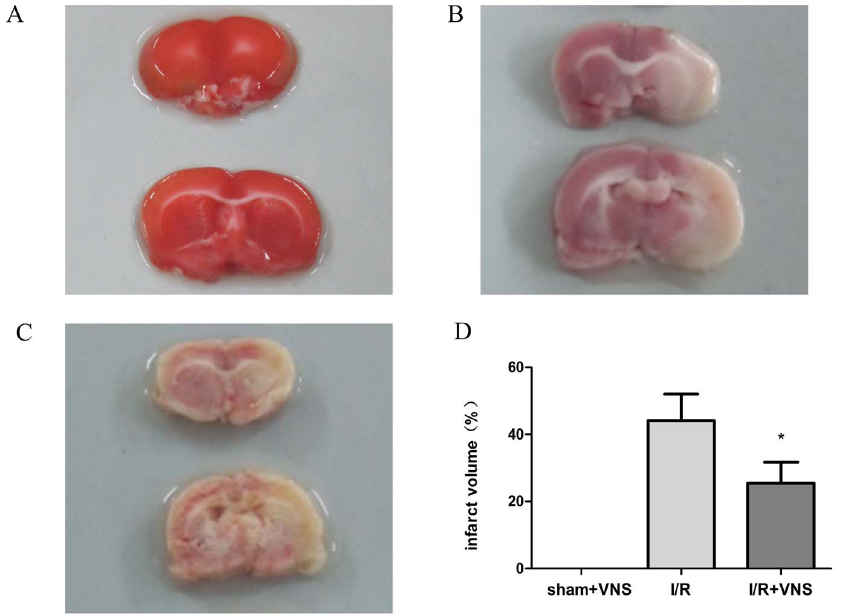
Figure 6. Neuroprotection induced by VNS on the infarct volume following I/R. TTC staining in the three groups at the level of bregma 0.4mm. A: sham + VNS group, B: I/R group, and C: I/R + VNS group. D. Histograms show that the relative percentage of infarct volume 24 h after acute I/R. Red area is the healthy tissue, and the white area is the infarct tissue. *p , 0.05 with relative to the I/R group, # p , 0.05 relative to sham + VNS group.